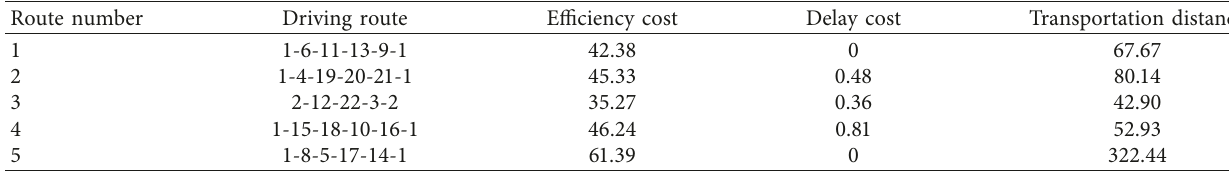
Table 4: Subpath transport route on the repairing number 1.